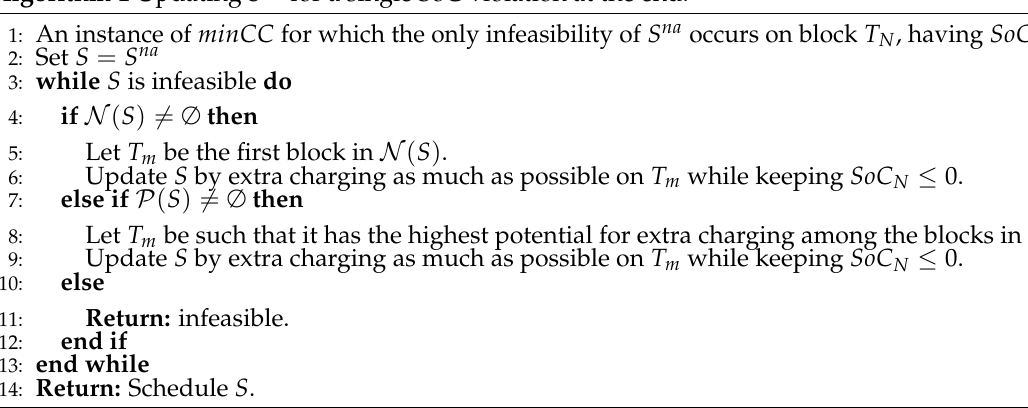
Algorithm 1 Updating S na for a single SoC violation at the